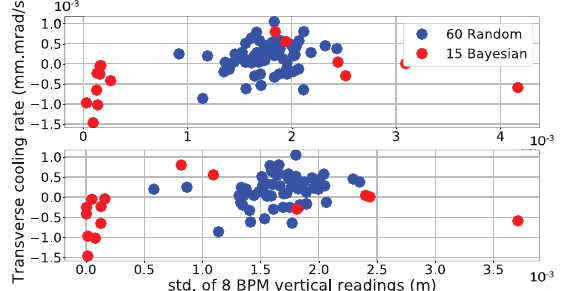
FIG. 4. Comparisons of rms and std values of BPM readings from the random samples (blue) and Bayesian samples (red). The Bayesian samples clearly have both rms and std values closer to 0 compared with the random samples. It indicates that the algorithm learns a way to optimize the cooling rate by reducing both rms and std values of electron trajectories, which matches our expectations.